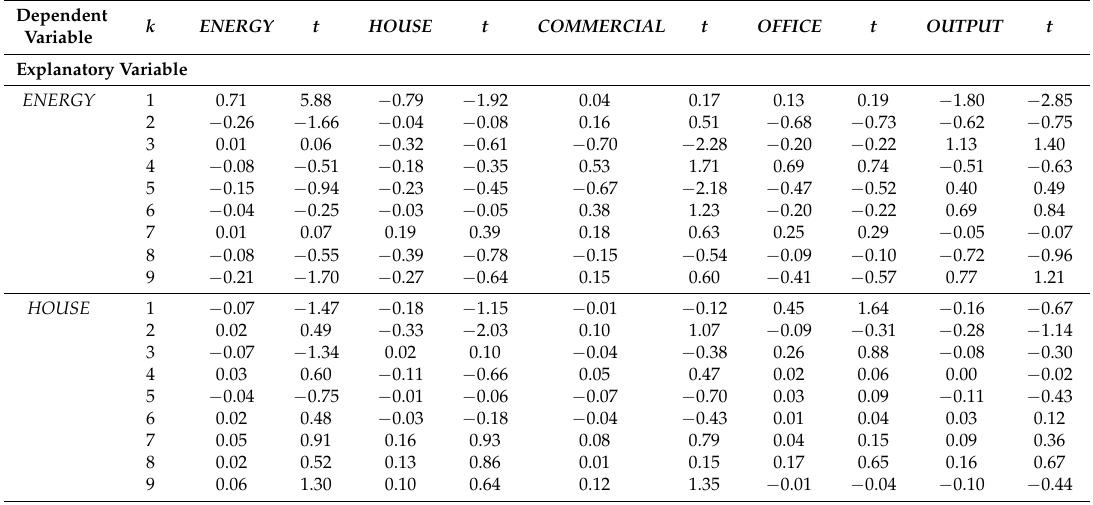
Table 6. Estimates of the log-linear first-differenced vector-autoregression (FDVAR) model. Dependent